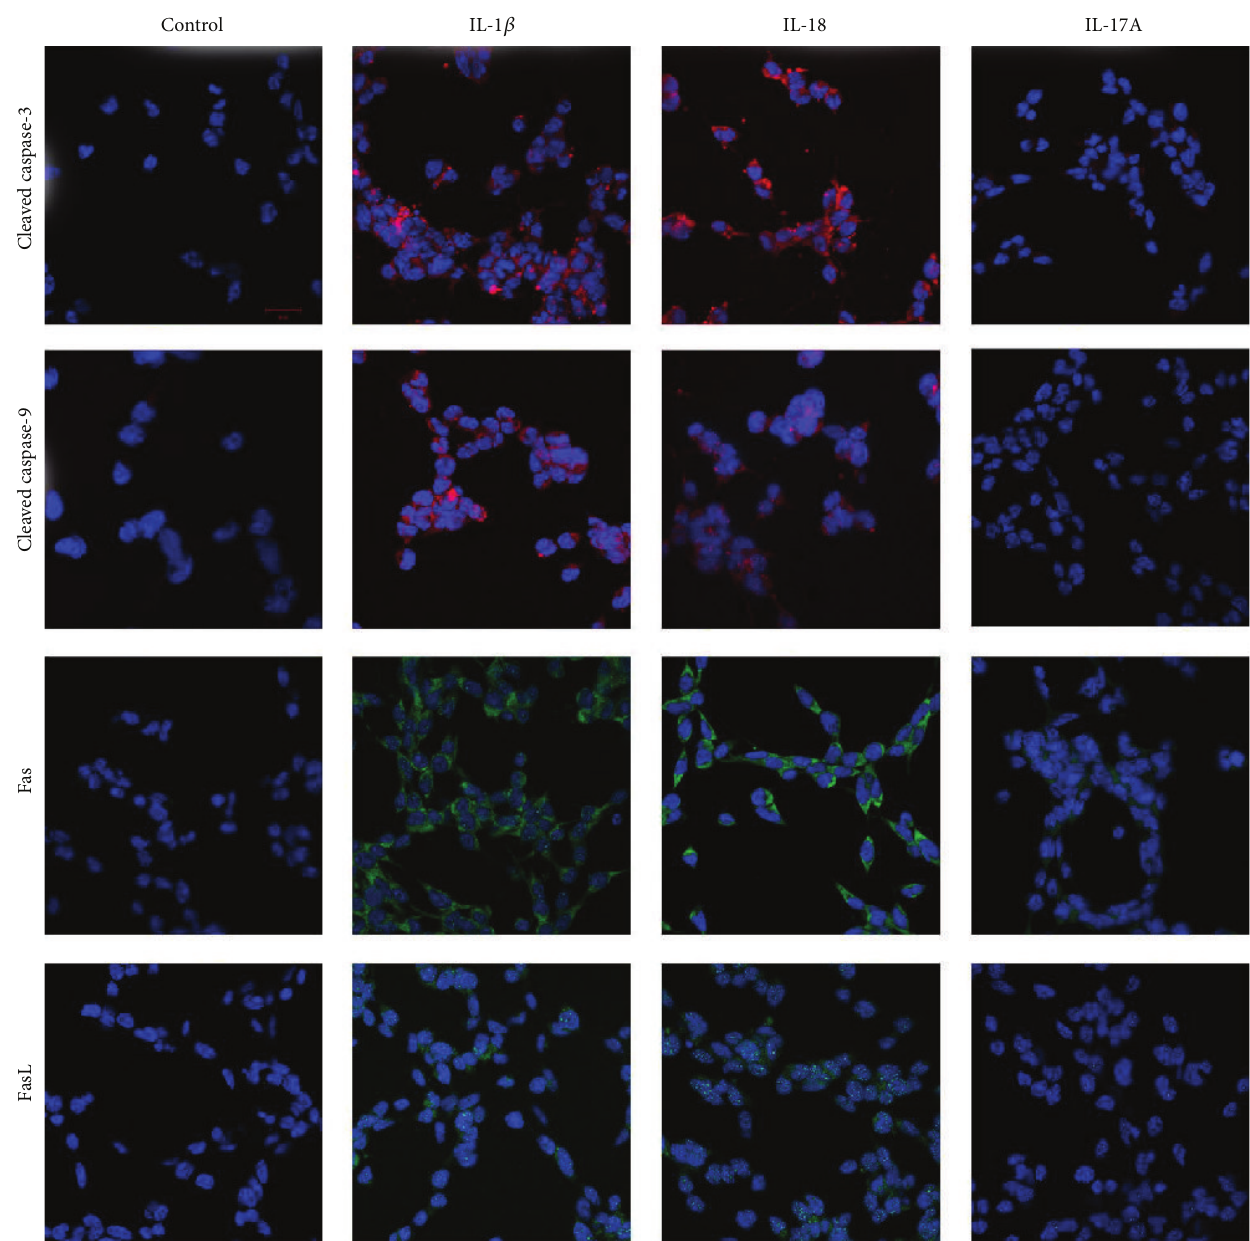
Figure 2: Proapoptotic protein expression in RSCs under stimulation. Immunofluorescence showed higher cleaved caspase-3 (red), cleaved caspase-9 (red), Fas (green), and FasL (green) expression in RSCs under stimulation with IL-1 𝛽 (100ng/mL) or IL18 (10ng/mL). IL-17A (10ng/mL) did not induce these proapoptotic proteins. The nuclei were stained with DAPI (blue) (scale bar: 20 𝜇